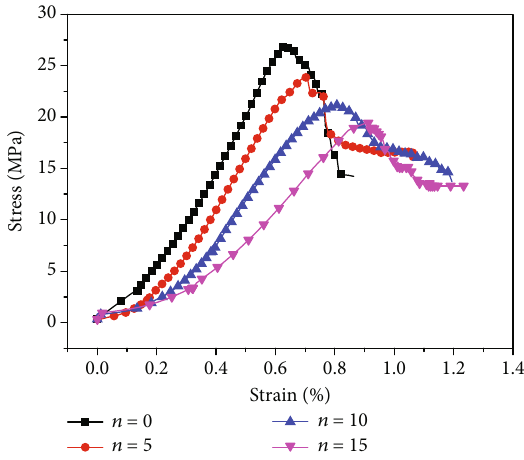
Figure 5: Stress-strain curve of carbonaceous mudstone.